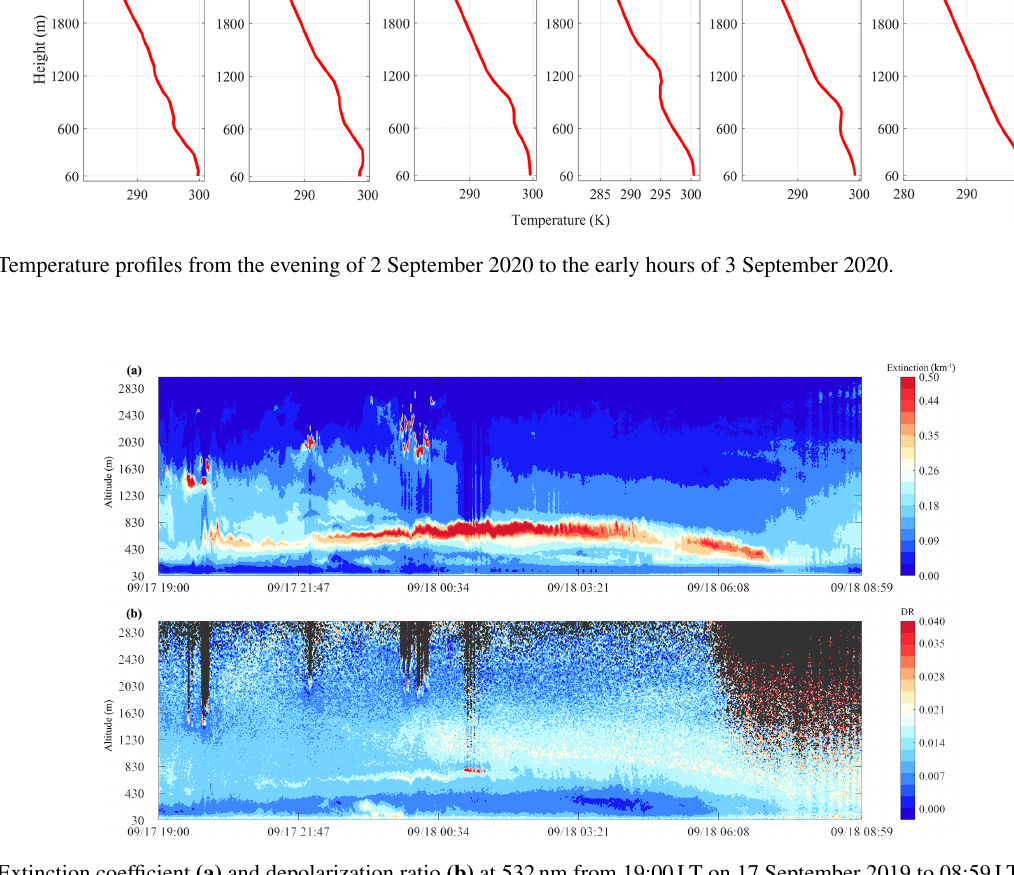
Figure 9. Extinction coefficient (a) and depolarization ratio (b) at 532nm from 19:00LT on 17 September 2019 to 08:59LT on 18 Septem- ber 2019.